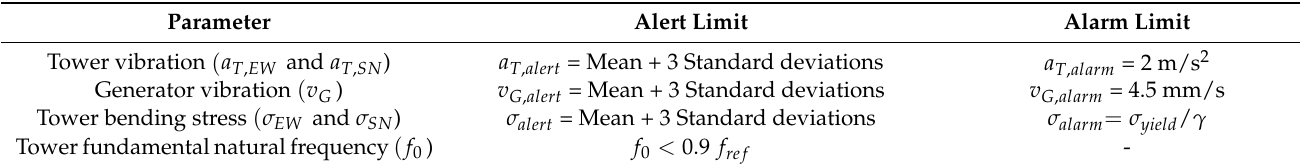
Table 2. Alert and alarm limits for each the measurement parameter.